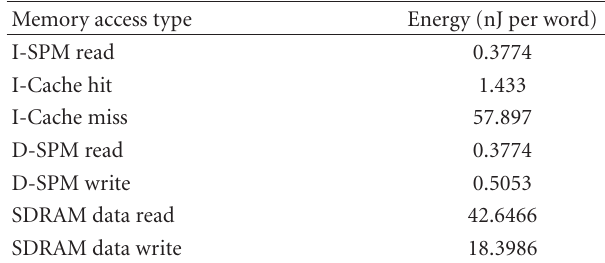
Table 2: Average energy consumptions for The multiperformance processor.